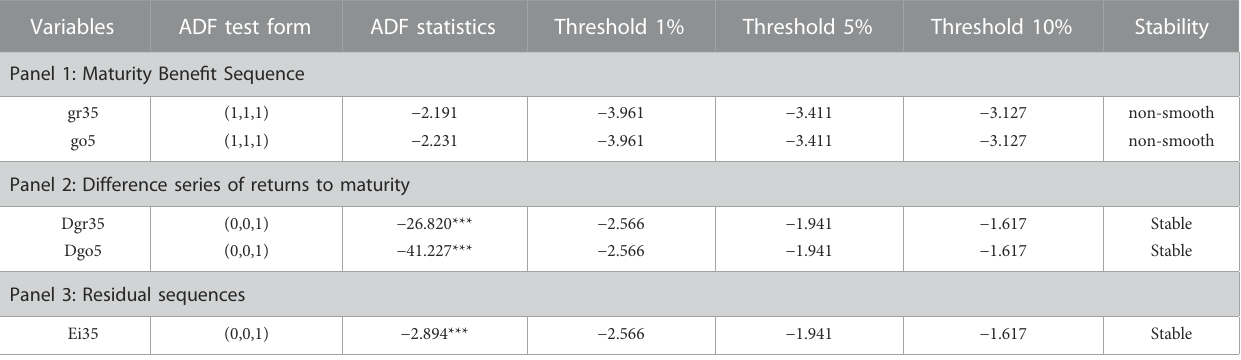
TABLE 2 Unit root test and co-integration test results for each series.